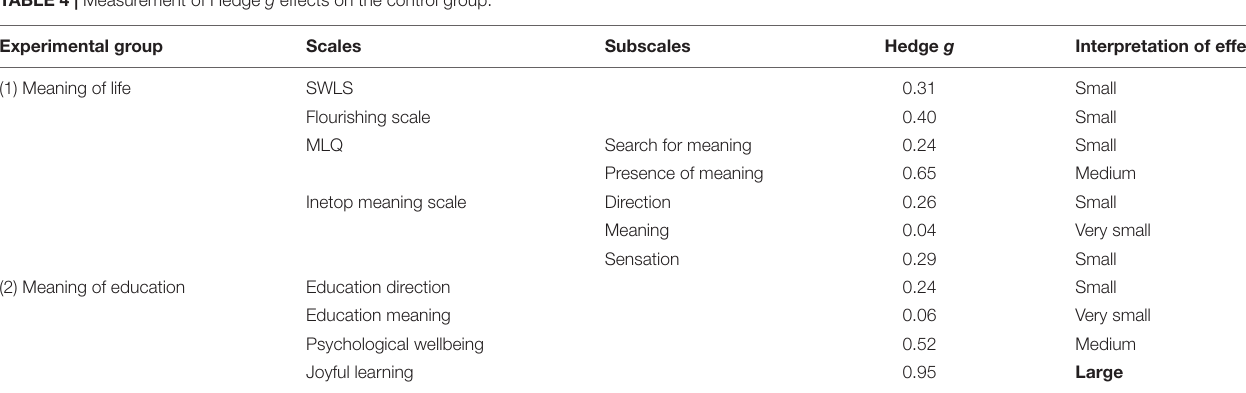
TABLE 4 | Measurement of Hedge g effects on the control group. Experimental